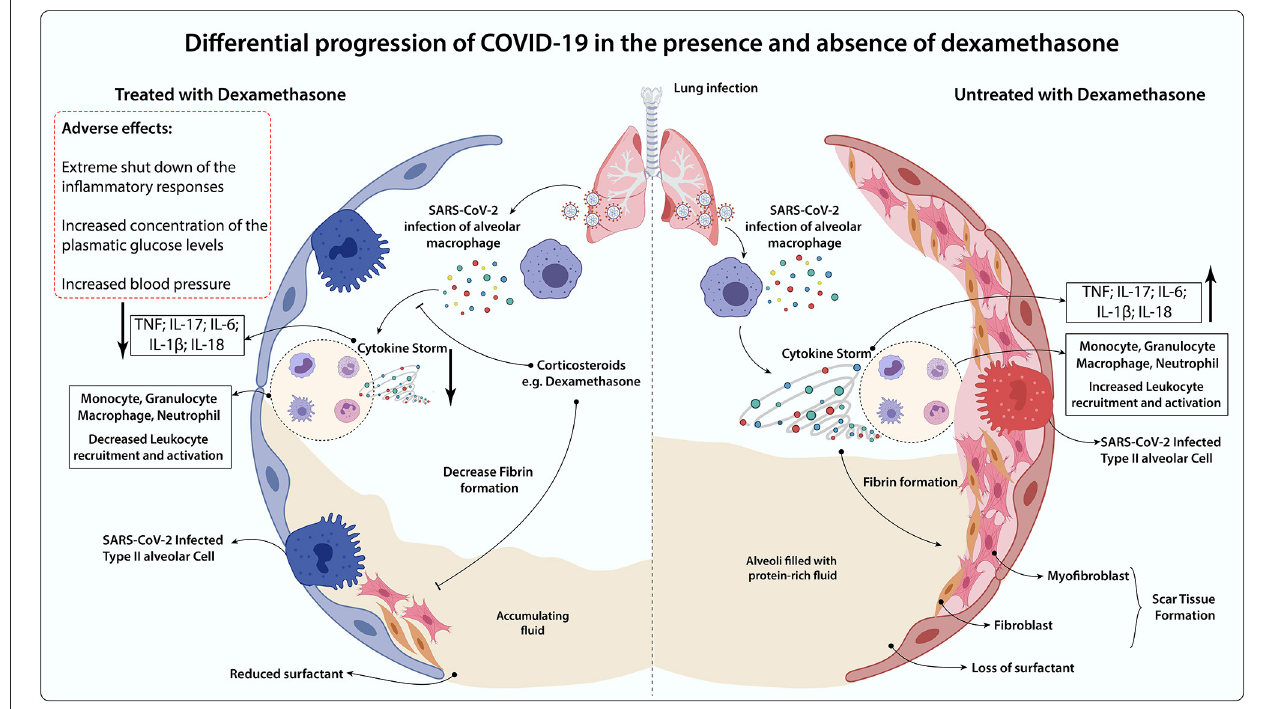
FIGURE 2 | Differential progression of COVID-19 in the presence and absence of dexamethasone. In the absence of an anti-inflammatory treatment, COVID-19-induced lung dysfunction is triggered by hyperactivation of alveolar macrophages infected by SARS-CoV-2 and immune cells (Monocytes, Granulocytes, Macrophages, Neutrophils) recruitment to the lung surroundings, which leads to the massive secretion of inflammatory mediators (TNF, IL-17, IL-6, IL-1b, IL-18) in the cytokine storm release. The persistence of the inflammatory process gives rise to the increased fibroblasts and myofibroblast invasion throughout the scar tissue formation, loss of natural pulmonary surfactant, and increased alveolar fluid. Dexamethasone administration may benefit through the impairment of cytokine storm occurrence and leukocyte lung infiltration, which decreases tissue fibrosis and alveolar fluid accumulation. However, this glucocorticoid is associated with immunosuppression, augmented blood pressure, and glycemia as major side effects. Thereby, it may be detrimental for some groups, including non-severe COVID-19 cases, diabetics, and hypertensive subjects.